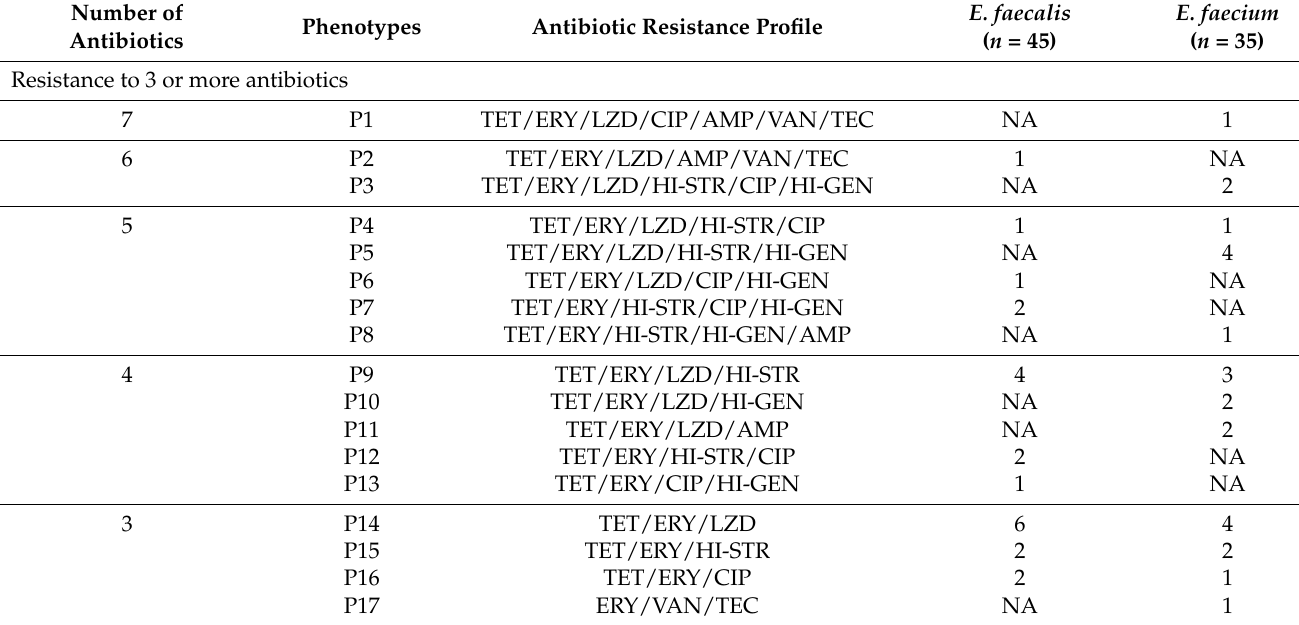
Table 2. Antibiotic resistance profiling of E. faecalis and E. faecium recovered from a poultry farm environment.